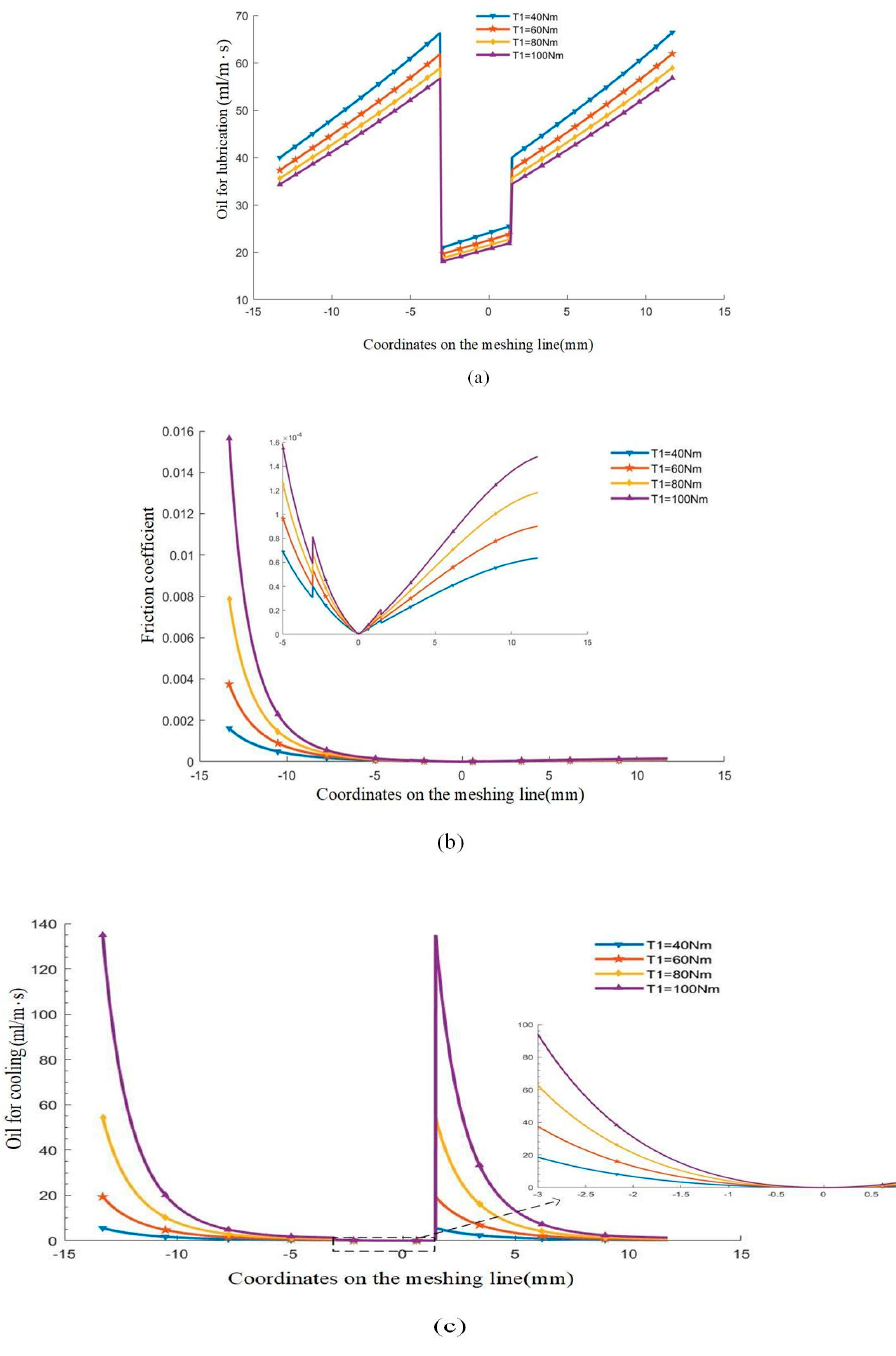
Figure 10. Oil volume for lubrication ( a ), friction coefficient ( b ), and oil volume for cooling ( c ) at different input torques during the meshing process.